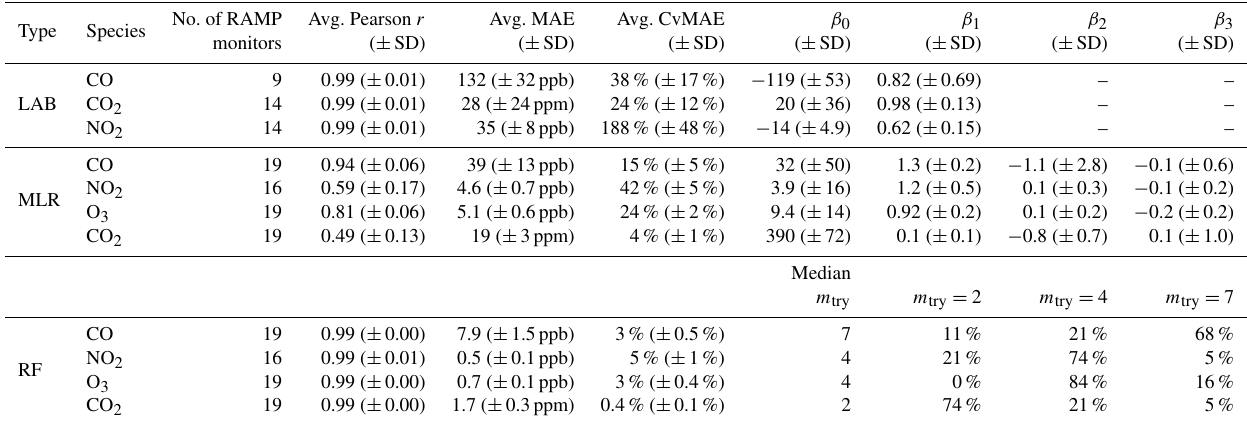
Table 2. Performance metrics for fits to training data (i.e., goodness of fit) discussed in Sect. 4.1. Type